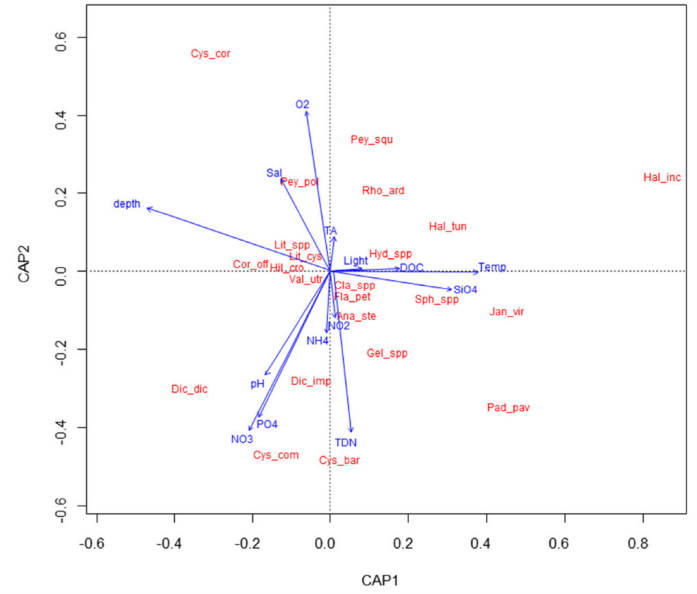
Figure 3. RDA biplot showing relationships among macroalgal taxa and environmental parameters. Total inertia: 3.647, eigenvalues for axis 1 = 0.751, eigenvalue for axis 2: 0.626. Cys_cor = Cystoseira corniculata ; Cys_comv = Cystoseira compressa ; Cys_bar = Gongolaria barbata ; Hal_inc =